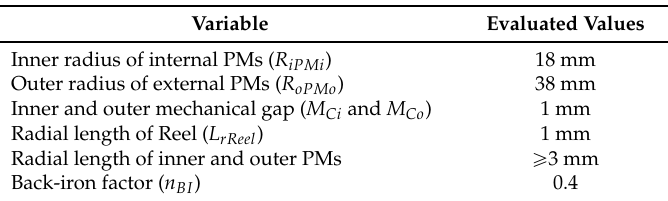
Table 2. Design constraints of the case